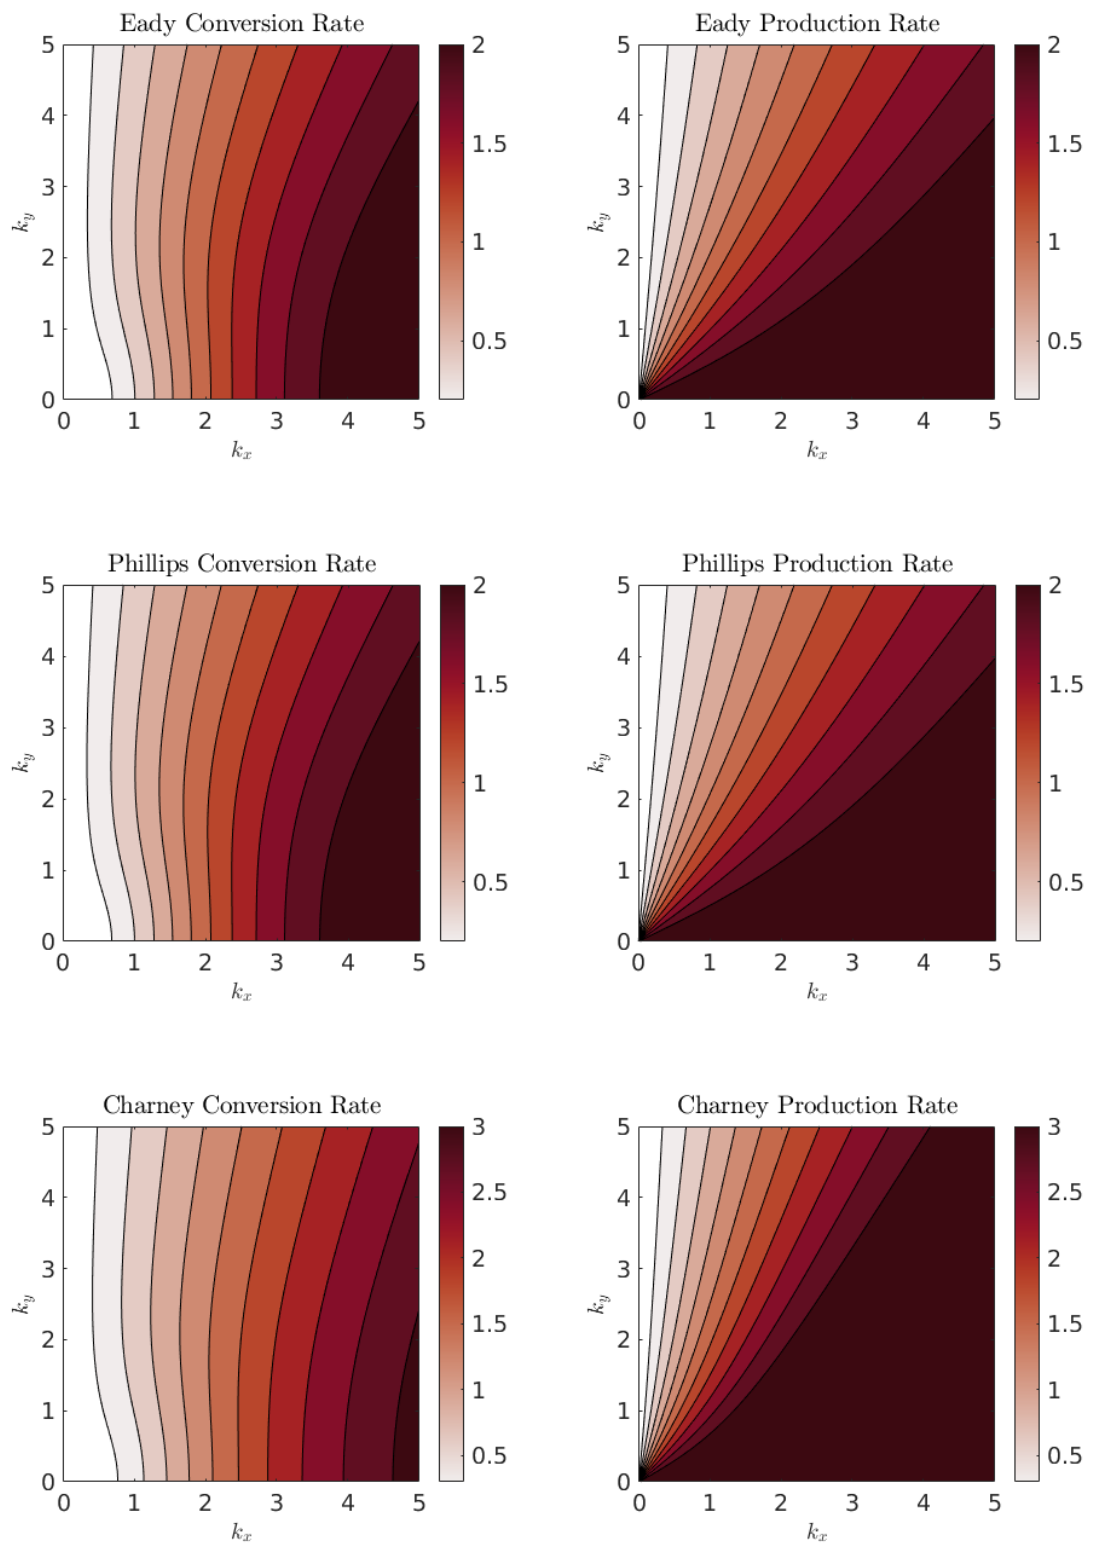
Figure 1. Conversion ( left ) and production ( right ) rates per unit energy as a function of k x and k y for the Eady ( upper row), Phillips ( middle row), and Ocean Charney ( lower row) mean flow profiles. In each panel, there are 10 contour intervals above zero up to the maximum value on the colorbar. In each row, the contour intervals in the left and right columns are matched. The horizontal wavenumbers k x and k y are nondimensionalized using f / ( NH )